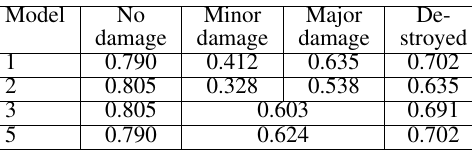
Figure 9. Haiti building detection ground truth